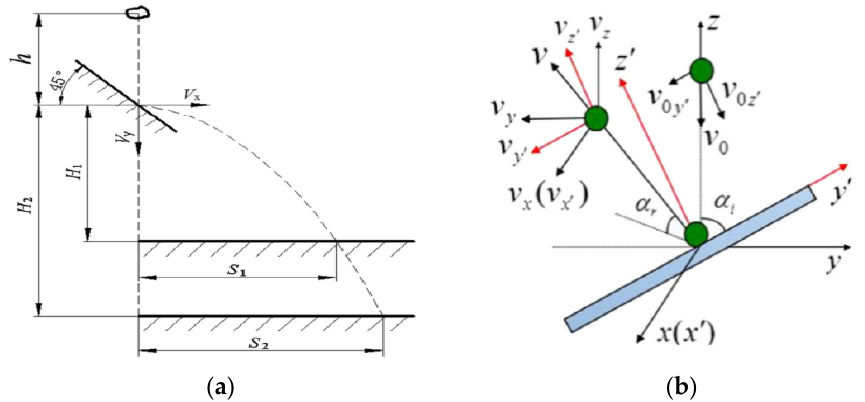
Figure 12. Schematic diagram of the device for testing the coefficient of restitution by the oblique impact method. ( a ) Two-dimension rebound [105]; ( b ) Three-dimension rebound [106].